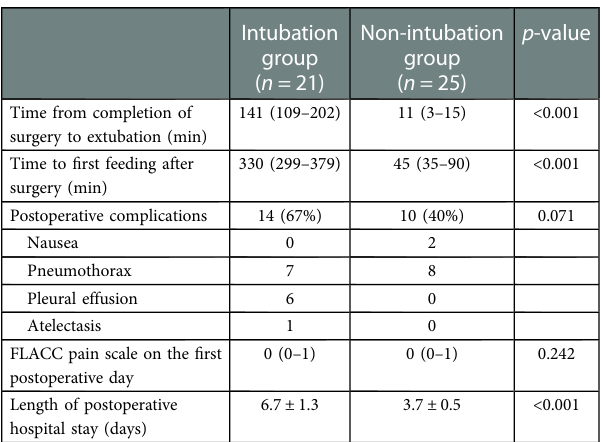
TABLE 3 Postoperative